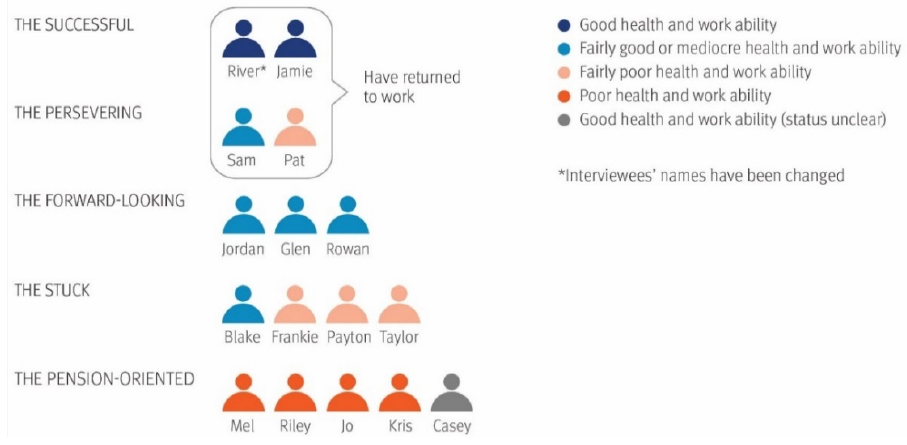
Figure 2. The interviewee groups based on their success in returning to work.